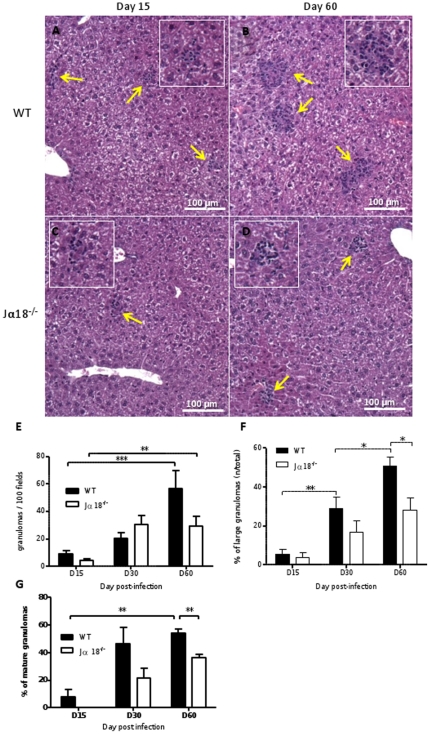
Jα18-/- mice display a qualitatively and quantitatively impaired hepatic granulomatous response after infection with L.donovani.Quantification of granuloma formation in the liver of L. donovani infected WT and Jα18-/-mice by microscopic examination of tissue sections stained with HES, at D15, D30 and D60 post-infection. Representative granuloma foci from WT mice at D15 (A) and D60 (B), and from Jα18-/- mice at D15 (C) and D60 (D) (×100 magnification). (E) Total number of granulomas in 100 microscopic fields (×400) at various time points. (F) Relative percentage of large granulomas (>25 cells) detected in each group of mice. (G) Relative percentage of mature granulomas detected in each group of mice.